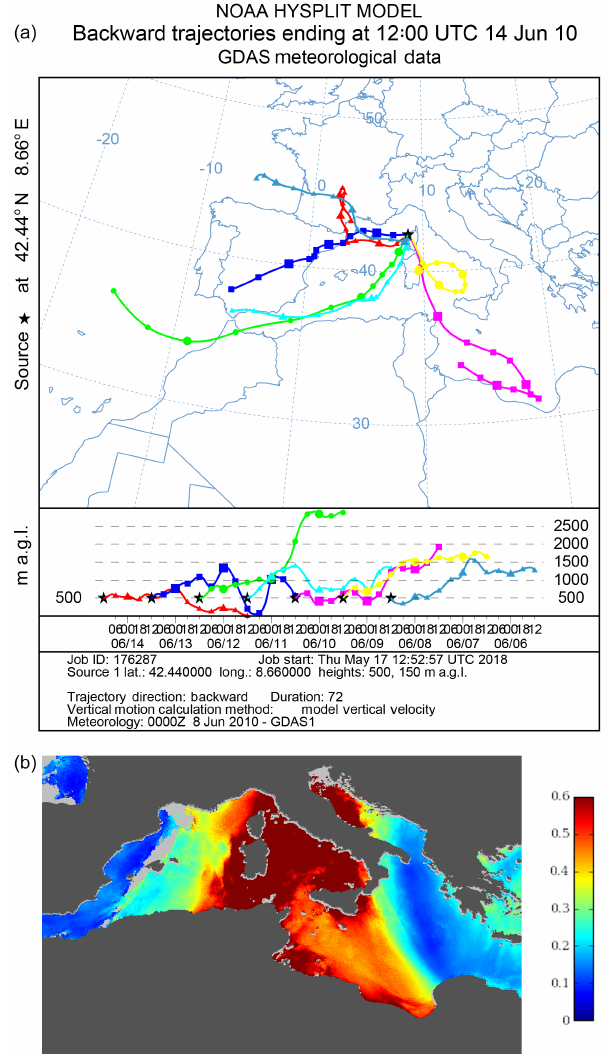
Figure 4. (a) Pathways of 3-day back trajectories ending at 500m at the sampling site at noon from the NOAA HYSPLIT model for the week of the As-rich event and (b) MSG/SEVIRI daily (daytime) mean aerosol optical depth over the ocean for 10 June 2010 in agree- ment with the intrusion of an intense Saharan dust event during this